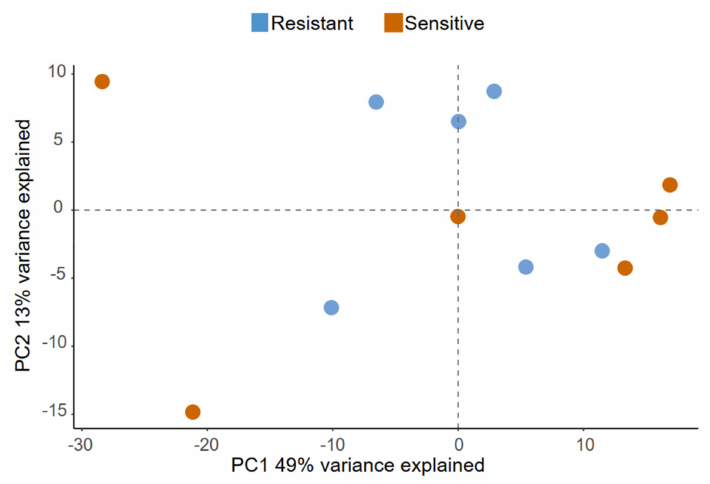
Figure 7. Exploratory data analysis of lipids identified in seminal plasma. Principal component analysis (PCA) showing how seminal plasma samples map onto principal components 1 and 2, which together contribute to explain 62% of the variance contained in the dataset. There is no distinct separation between samples collected from ejaculates with resistant (blue dots) and sensitive (orange dots) sperm to 10% ( v / v ) autologous seminal plasma in extended semen at 144 h of